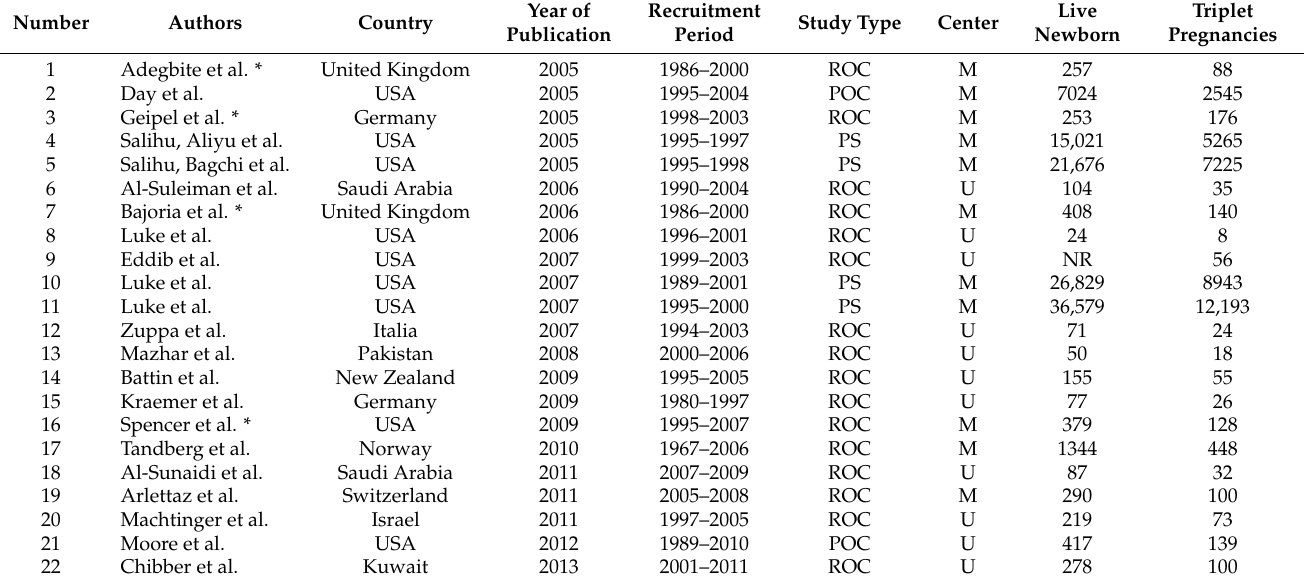
Table 1. Characteristics of the studies included in the systematic review and meta-analysis.